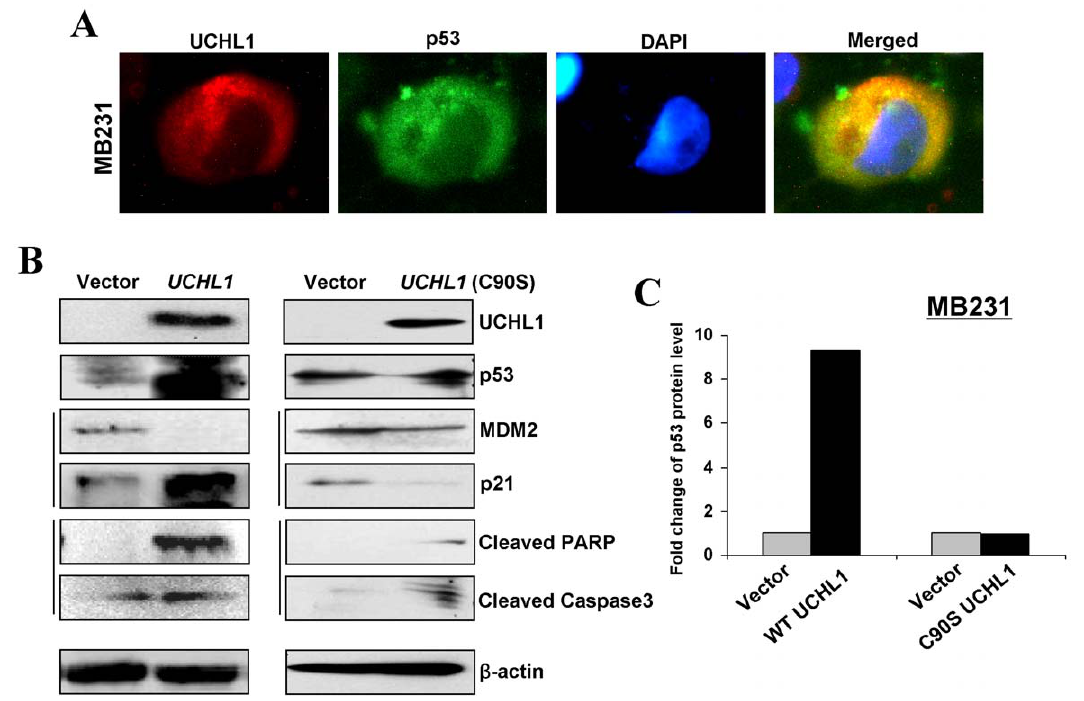
Figure 7. UCHL1 promotes the activation of p53 signaling depending on its deubiquitinase activity. (A) The subcellular localization of UCHL1 and p53 was analyzed in UCHL1 -transfected MB231 cells. (B) Western blot analysis of cell cycle- and apoptosis-related proteins in vector-, UCHL1 and UCHL1 C90S -transfected MB231 cells. b -actin was used as a control. (C) Quantification of p53 protein expression by Western blot using scanning and ImageJ software. Each sample was normalized to b -actin content.